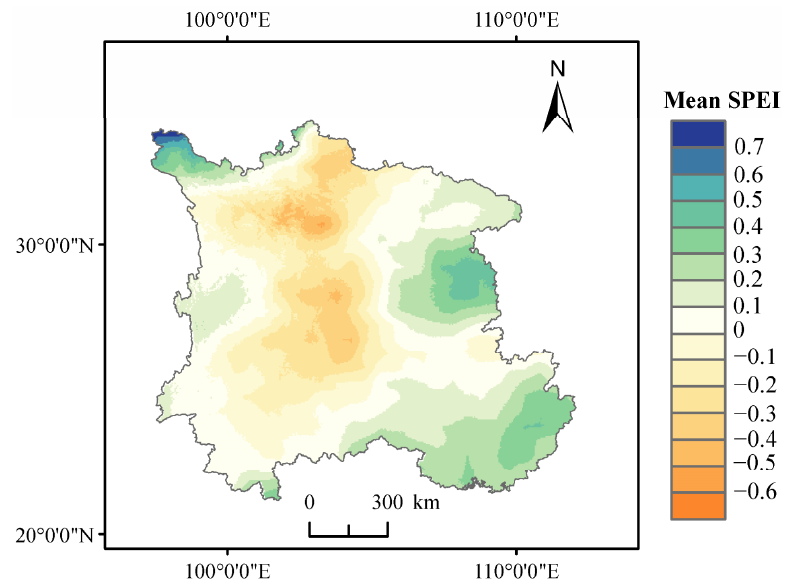
Figure 10. Spatial distribution of annual mean SPEI from 1990 to 2018.